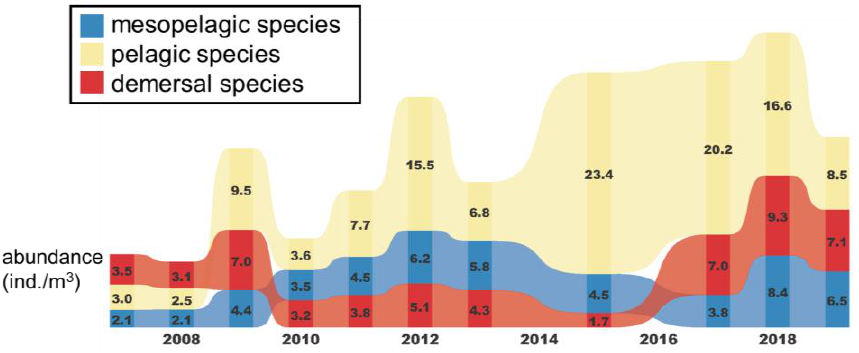
Figure 9. Results of time series analysis of the abundance of fish larvae and juveniles in the pelagic, mesopelagic, and demersal depth zones in the waters around Taiwan from 2007 to 2019.